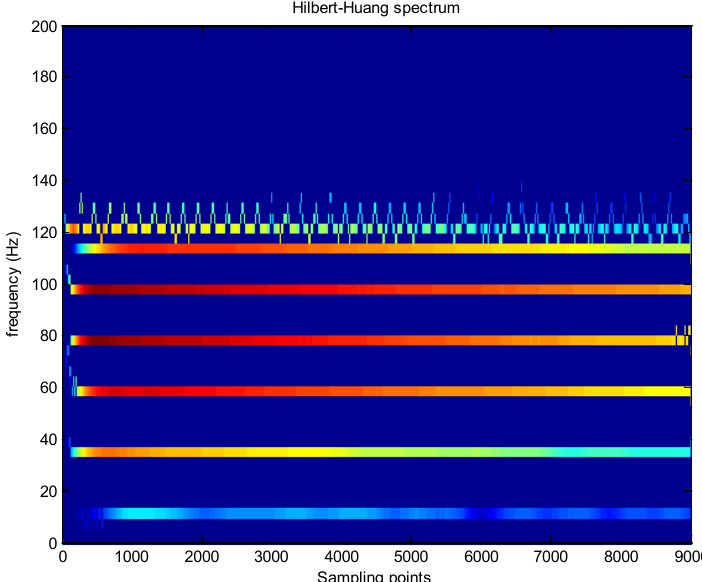
Figure 15. Hilbert spectrum using IEMD + Hibert.